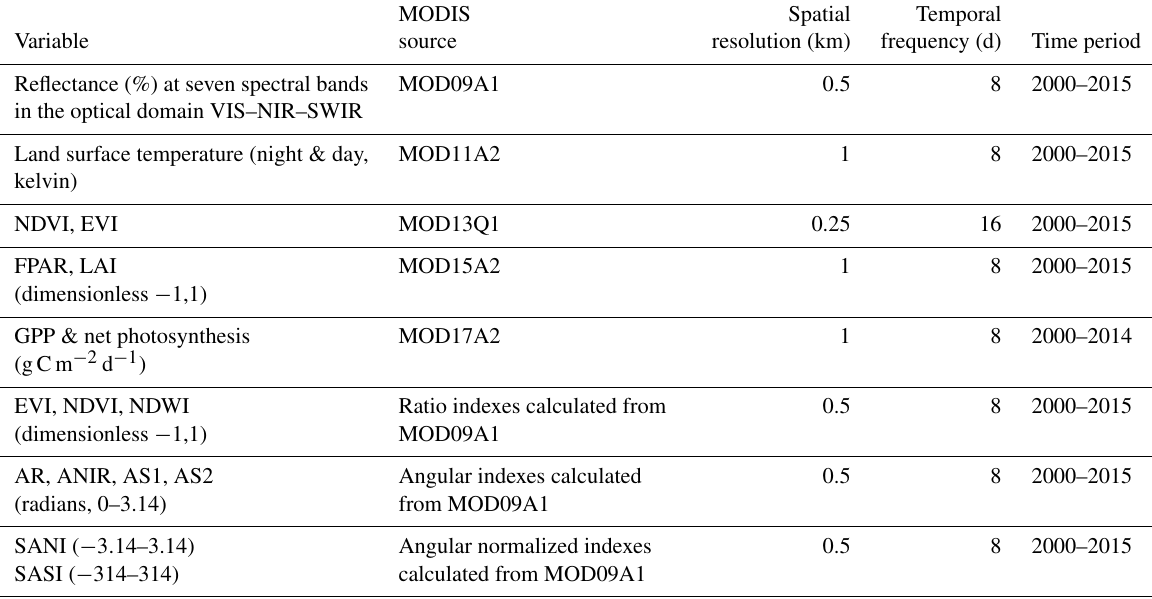
Table 6. Summary of the remote sensing data included in the PROFOUND DB. VIS, NIR and SWIR are the visible, near-infrared and shortwave infrared regions of the electromagnetic spectrum. NDVI: normalized difference vegetation index; EVI: enhanced vegetation in- dex; FPAR: fraction of photosynthetically absorbed radiation; LAI: leaf area index; GPP: gross primary productivity; NDWI: normalized difference water index; AR: angle at red; ANIR: angle at NIR; AS1: angle at shortwave infrared 1; AS2: angle at shortwave infrared 2; SANI: shortwave angle slope index; SASI: shortwave angle slope index.